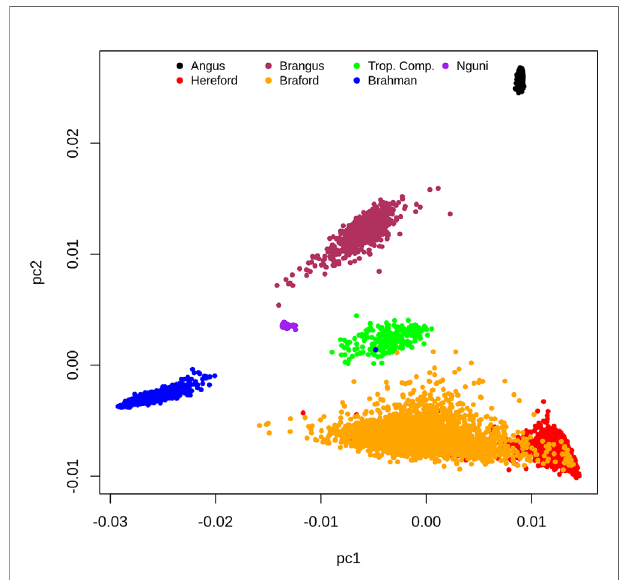
FIGURE 1 | Dispersion of individuals according to the fi rst and second principal components of the G matrix, colored by